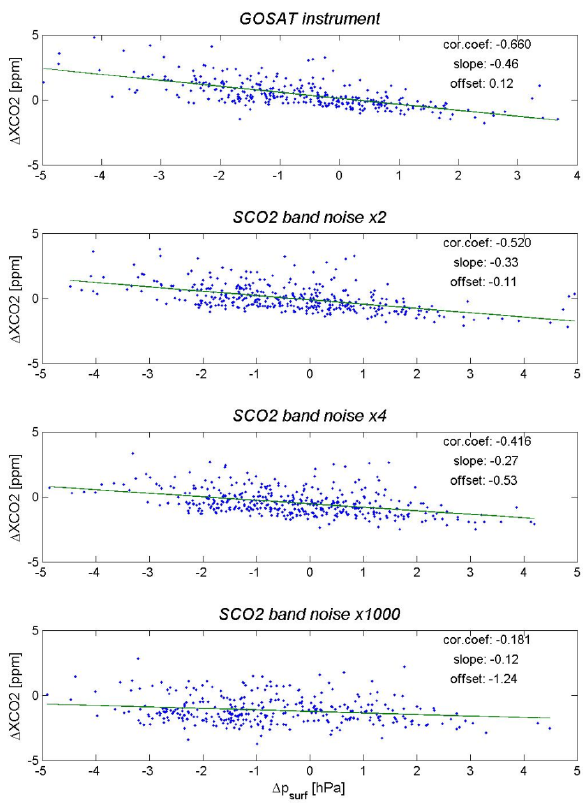
error (ppm) and the surface 2